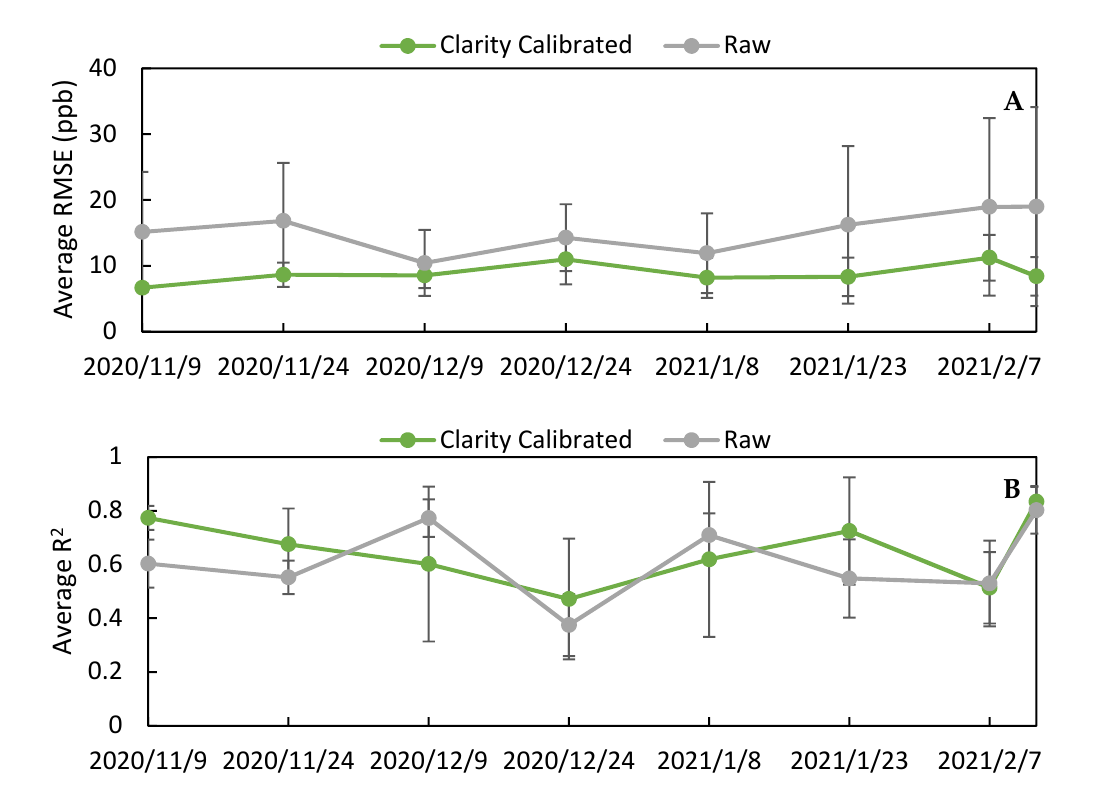
Figure 9. Average RMSE ( A ) and average R 2 ( B ) between the 8 sensors evaluated biweekly for the whole deployment period for raw NO 2 and Clarity 15-day calibration.